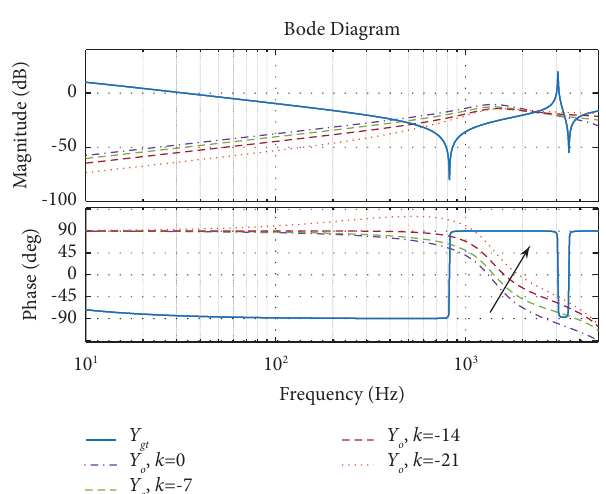
Figure 6: Te output admittance Y equivalent network admittance Y gt ( s ).